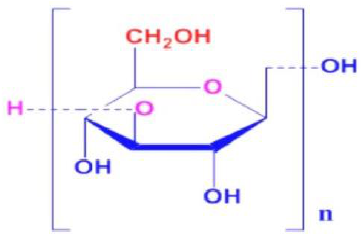
Figure 1. Molecular structure of β -glucan [23].